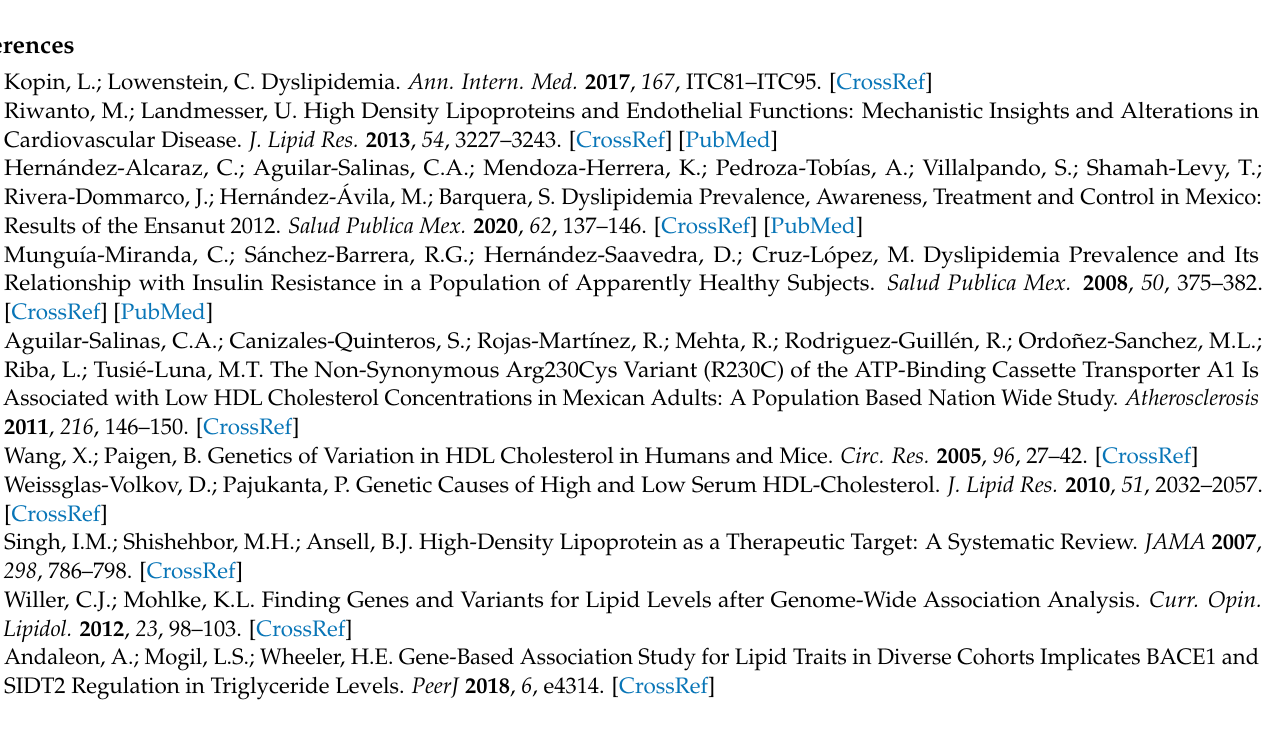
Table S3. Conditional Analysis; Table S4: Association between nutrients with HDL-c